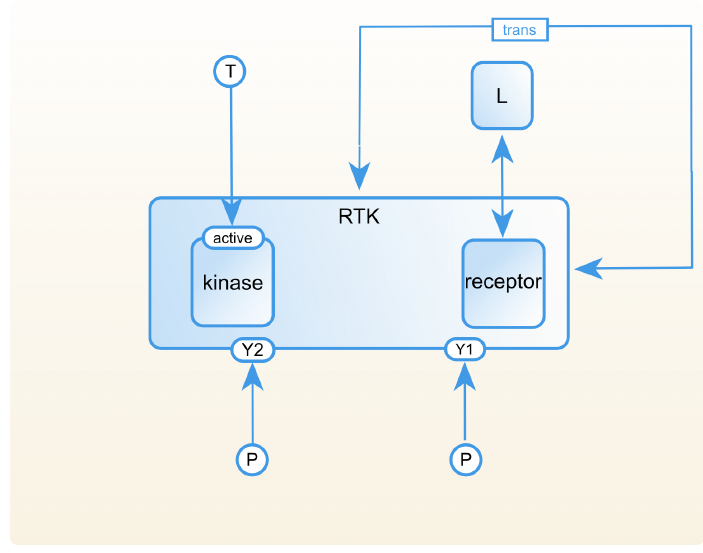
Figure A.4: Receptor tyrosine kinase activation: receptor dimer